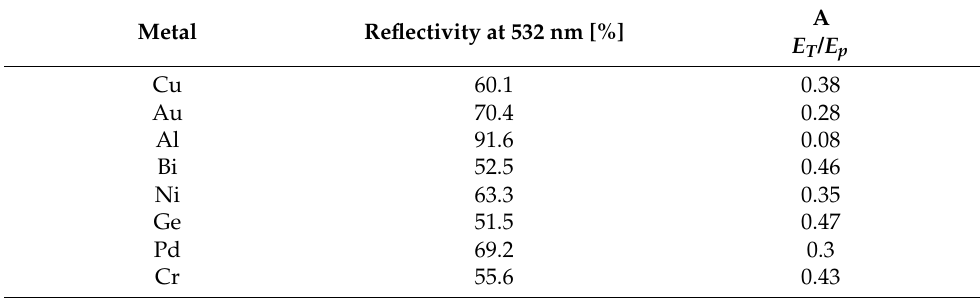
Table A2. The reflectivity and the relation between the transmitted laser energy that heats the metal and the whole energy of the laser pulse at wavelength of 532 nm.